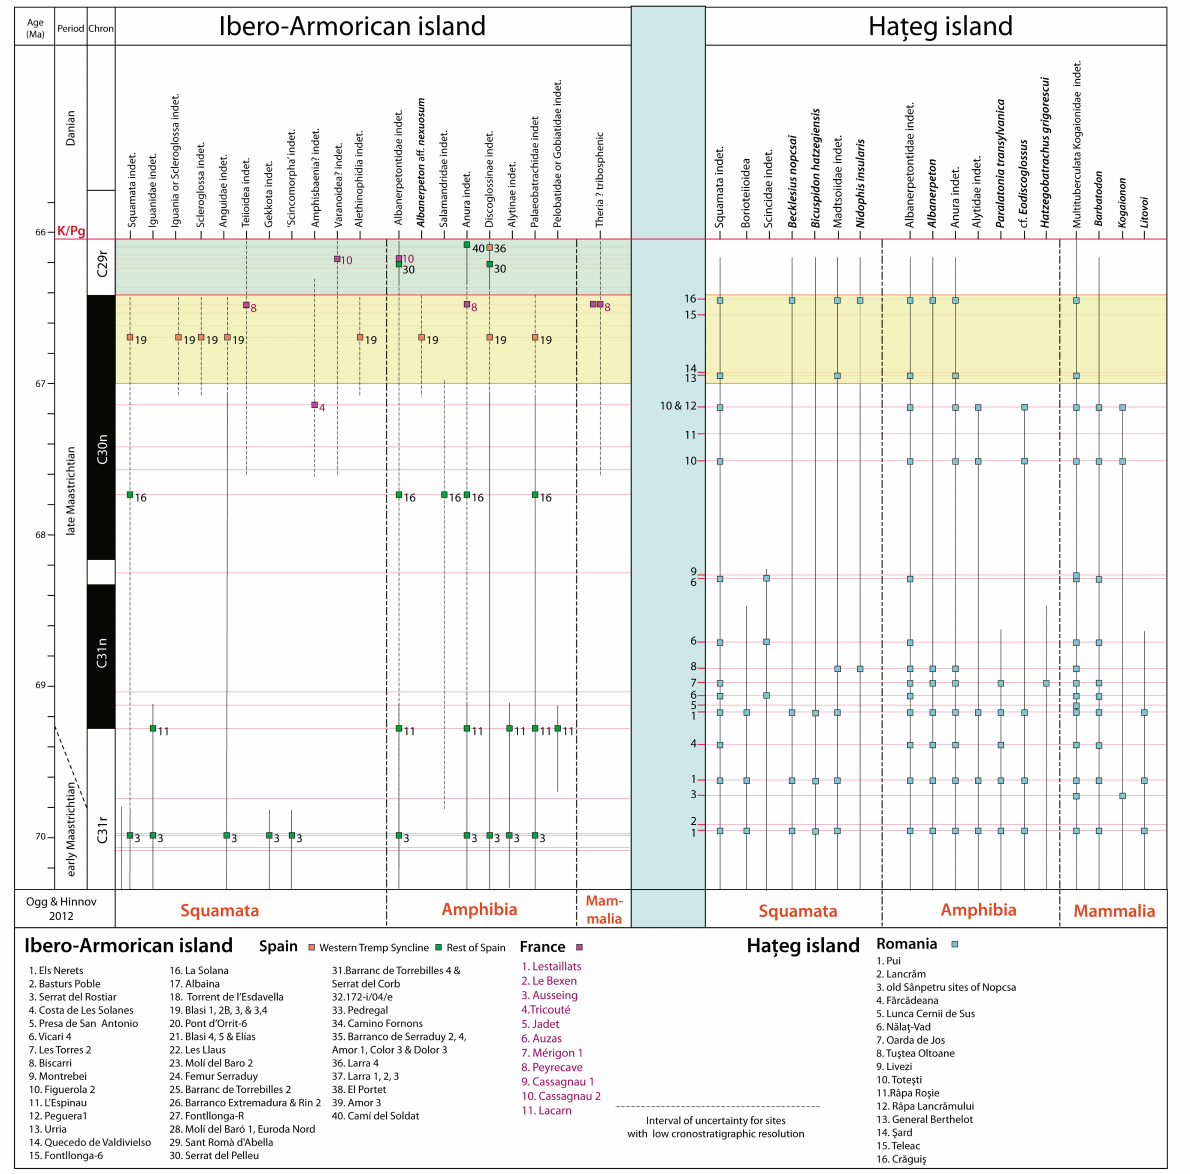
Figure 10. Squamate, amphibian and mammal groups and species occurrences in the Ibero-Armorican island and Ha¸teg island during the late Maastrichtian. Ha¸teg island data based on [32] with updated information. The yellow band marks the temporal interval used for comparison, whereas the green band marks the last ≈ 350 ka of the Maastrichtian, with a record only in the Ibero-Armorican island. Magnetochronostratigraphic scale based on [153] and calibration for the K-Pg boundary based on